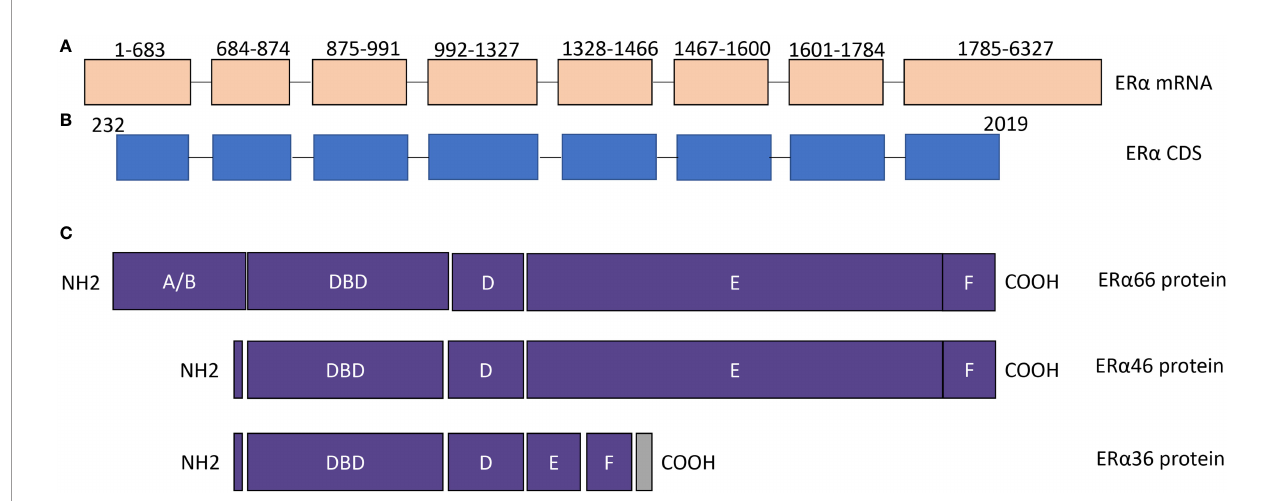
FIGURE 1 | The structure of ER a isoforms. (A) ER a mRNA contains 8 exons. NCBI reference sequence: NM_000125.4, transcript variant 1. (B) ER a coding region. (C) The protein structure of ER a 66, ER a 46, and ER a 36. The difference among ER a 66, ER a 46, and ER a 36 is mainly located in AF1 and AF2 domains. DBD, DNA binding